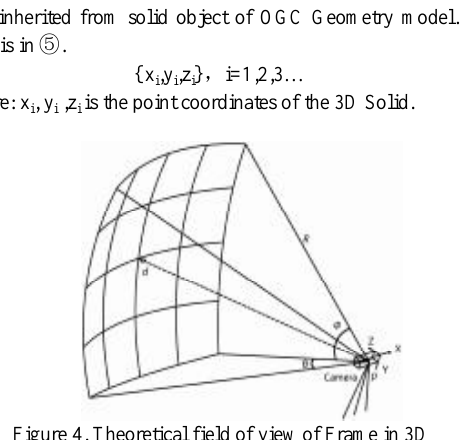
Figure 4. Theoretical field of view of Frame in 3D For Video segment, all VFFOVCones for each video frame can be union to one irregular Solid. Thus the VSFOVCone object is defined to present the video segment 3D field of view. Its form is in ⑥ .